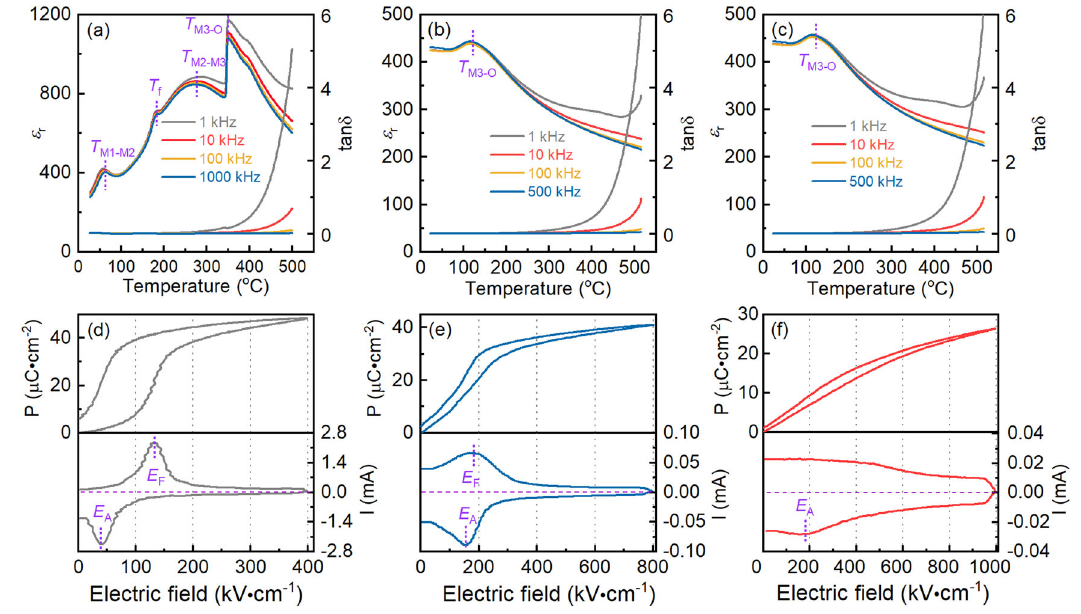
Fig. 4 | Dielectric permittivity, unipolar P – E loops, and current curves of AN, ANT, and SANT samples. Temperature- and frequency-dependent dielectric per- mittivity and loss for AN MLCCs ( a ), ANT MLCCs ( b ), and SANT MLCCs ( c ), and